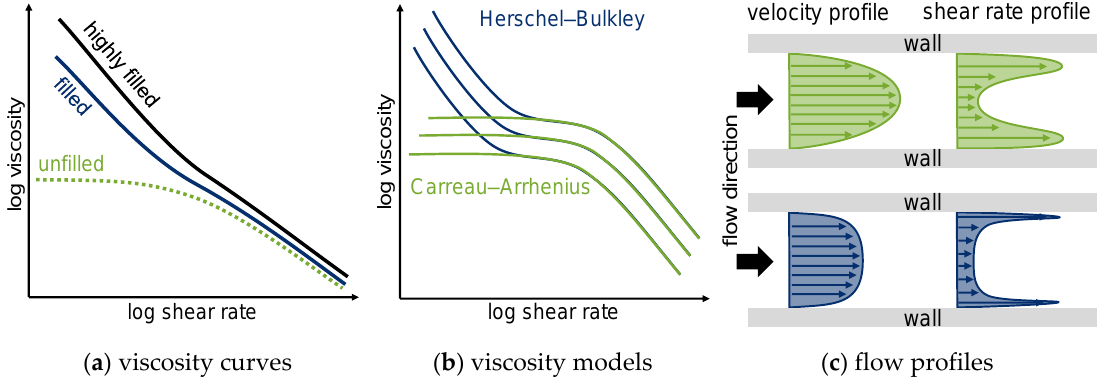
Figure 5. Influence of the viscosity to the velocity profile according to [59].